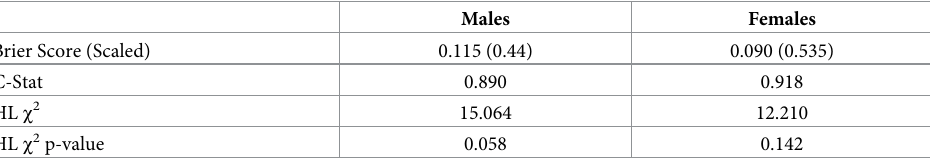
The sex specific OPoRT functions for males and females are presented in Table 2. The strongest predictors of obesity were measures of baseline BMI, baseline age, obesity, and time. Both equations include all of these variables and interactions among them. Continuous BMI and age were found to result in the greatest model performance as assessed by brier score and c-statistic. Smoking status and living arrangements were found to be important predictors for both sex. Sex-specific variables include any post-secondary education and non-drinking status for males and physical inactivity and ethnicity for females. The validation characteristics for each model are presented in Table 3. The overall perfor- mance of both models as measured by the Brier score is good and the calibration of the models as measured by the Hosmer-Lemeshow Chi Square (HL χ 2 ) is acceptable. Meanwhile, the discrimi- nation as measured by the c-statistic of both models is excellent. Models for both sex performed similarly well in the bootstrap validation, with optimism corrected brier statistic equalling 0.118 Table 3. Obesity Population Risk Tool (OPoRT) Internal validation characteristics for males and